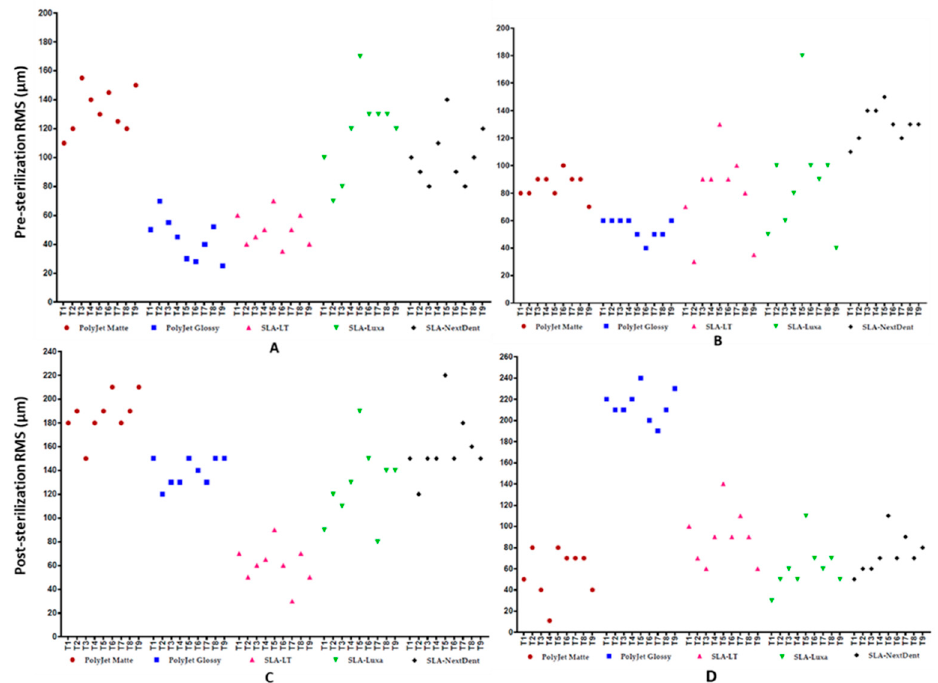
Figure 6. Scatter plot demonstrating the deviations distribution pattern of test bodies regarding their position on 3D printer’s build platform: ( A ) pre-sterilization outer measurements; ( B ) pre-sterilization inner measurements; ( C ) post-sterilization outer measurements; and ( D ) post-sterilization inner measurements.